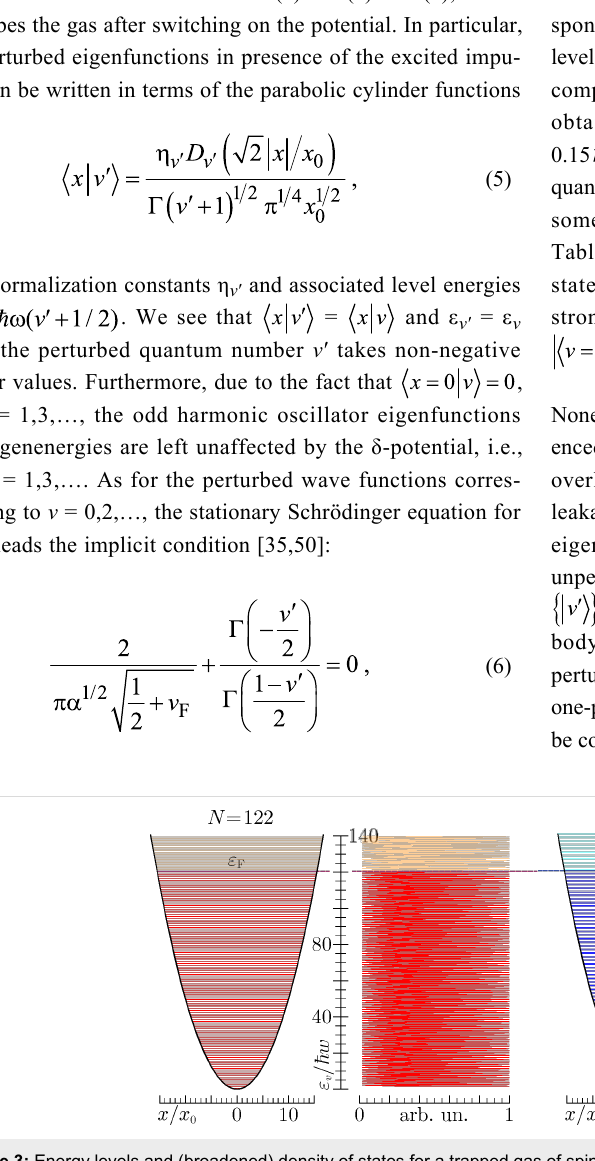
Figure 3: Energy levels and (broadened) density of states for a trapped gas of spin 1/2 fermions having a number of occupied states ( N = 122) similar to that of the valence band of C 60 . The critical parameter is set to α = 0.1, which corresponds to an impurity potential height of